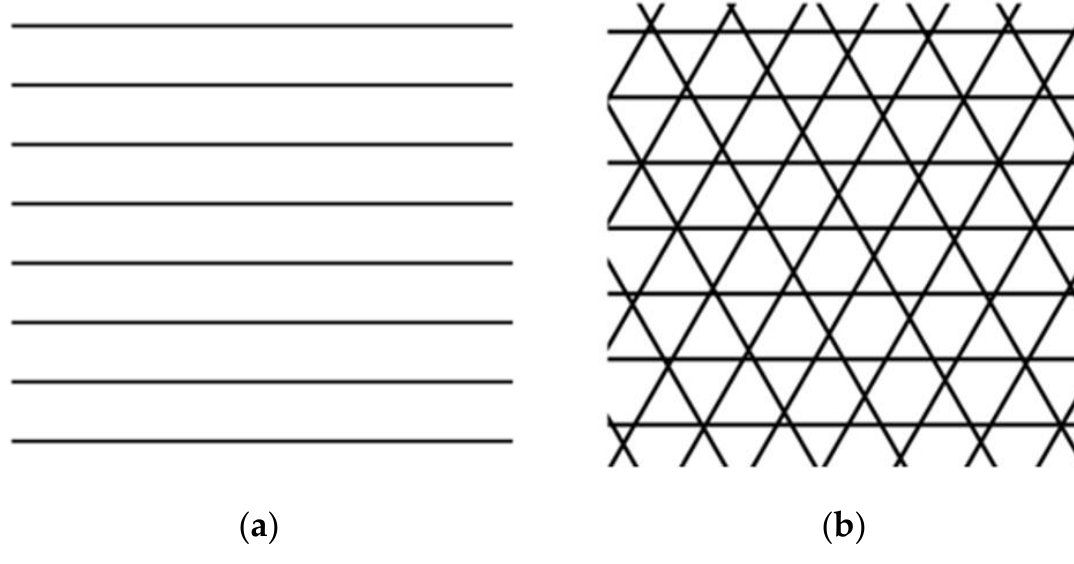
Figure 2. Patterns produced in the research: ( a ) line ( b ) triangles.